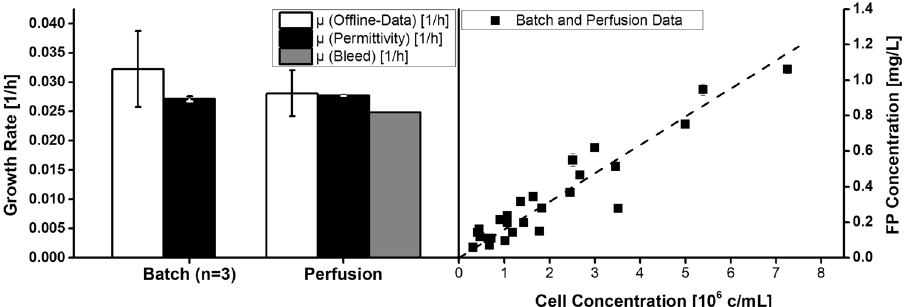
Figure 5. Differences in the growth rate µ based on the calculation input data (left) and calculated fusion protein concentration for the exponential phase of all cultivations over the corresponding offline cell concentration